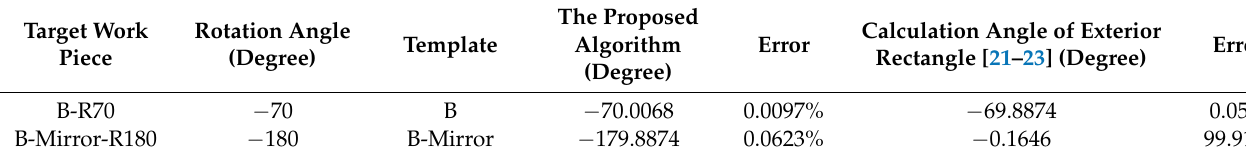
Figure 9. B, B-Mirror phase difference algorithm matching results. ( a ) −70° Rotation of the B; ( b ) −180° rotation of the B-Mirror. Table 3. B, B-Mirror phase difference match